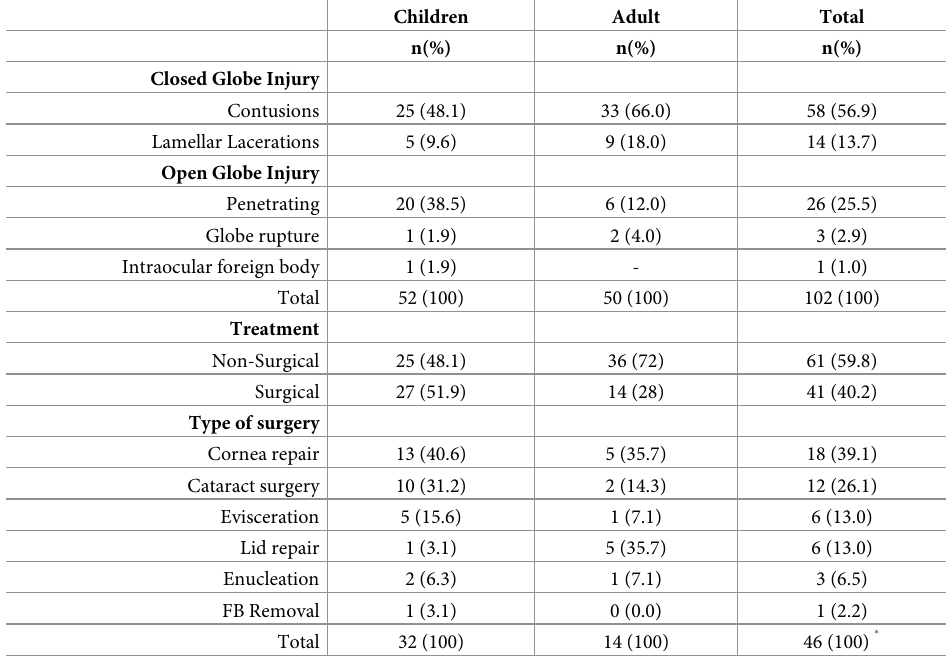
Table 3. Classification of injuries and management.